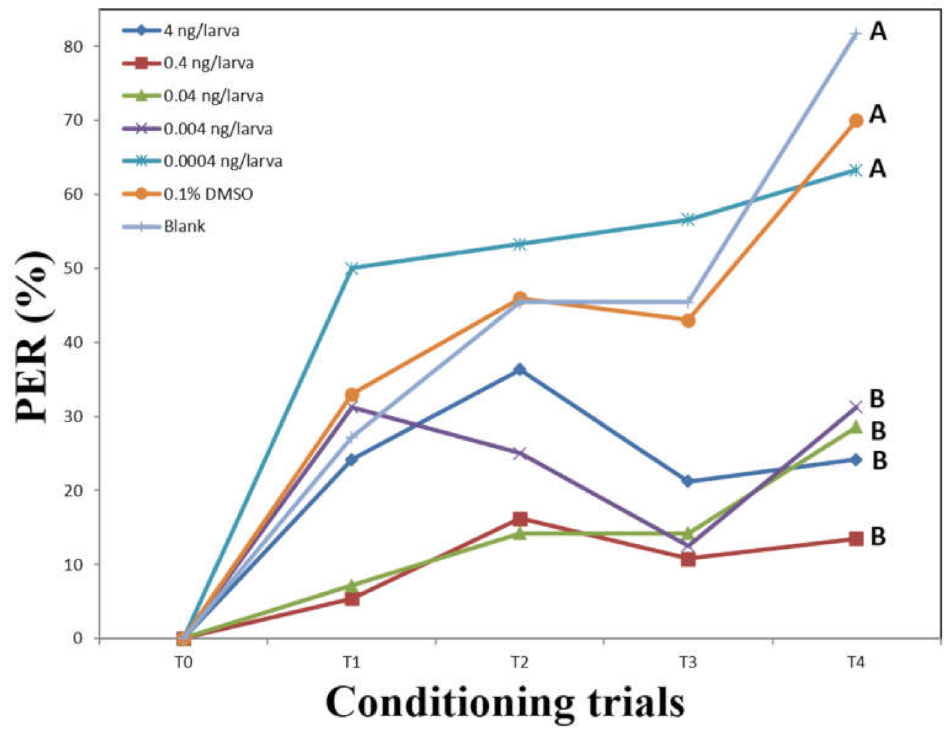
Figure 1. Olfactory associative behavior in honey bee adults following larval contamination with fluvalinate. T0 is trial to test normality of honey bees. T1, T2, T3, and T4 are conditioning trials. A and B indicate significant differences ( p < 0.001) between treatments (two-tailed Kruskal–Wallis H test, p < 0.001, compared with two-tailed Mann–Whitney U test with Dunn–Šid á k correction at a 95% confidence